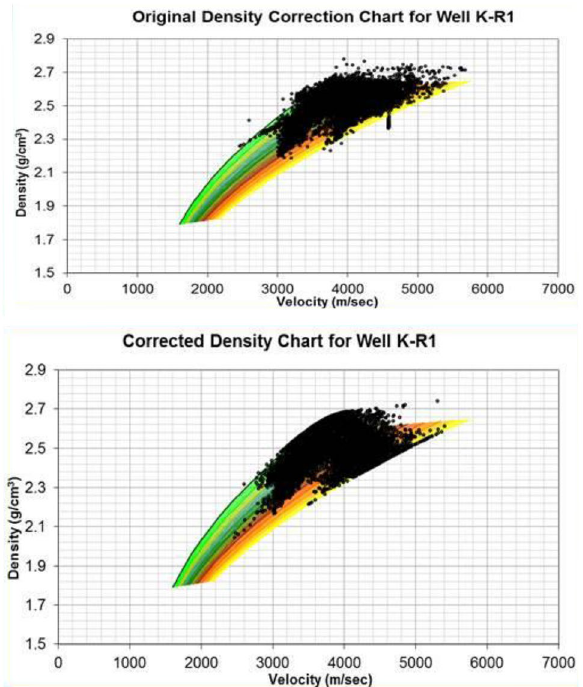
Fig. 4 Original and corrected density